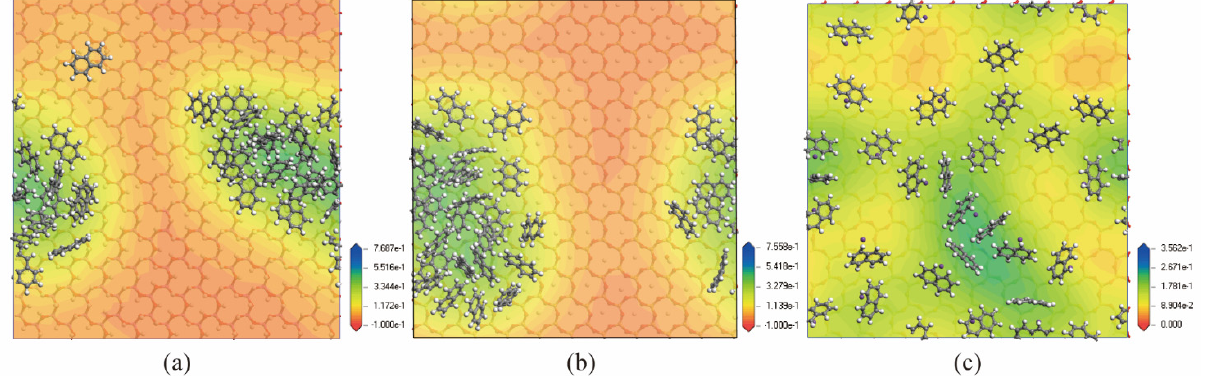
Figure 7. The equilibrium configuration and density distribution of naphthalene on different mineral surfaces. ( a ) Kaolinite (Aluminum octahedral surface); ( b ) Kaolinite (Silicon tetrahedral surface); ( c ) Montmorillonite.